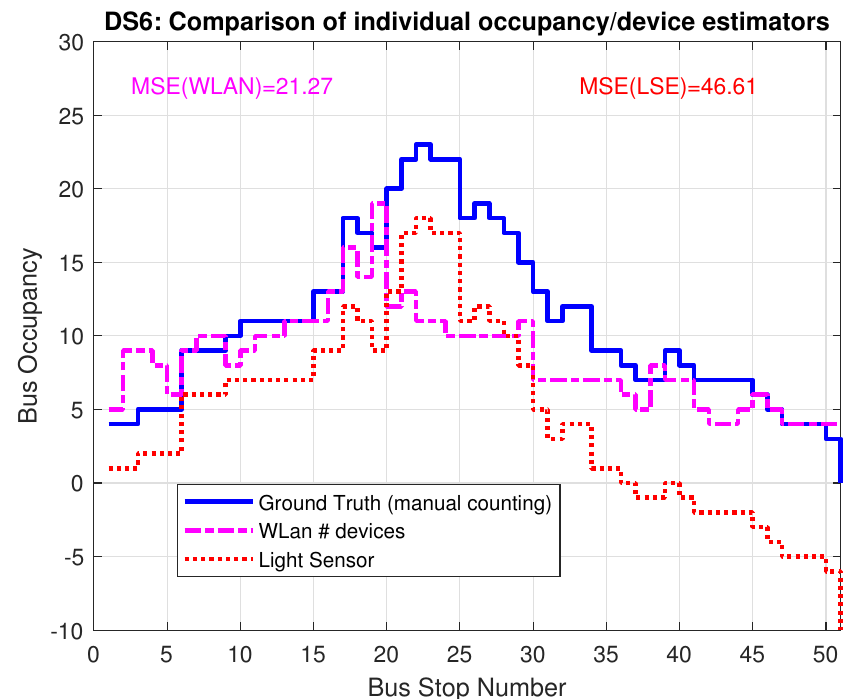
DS6: Comparison of individual occupancy/device estimators